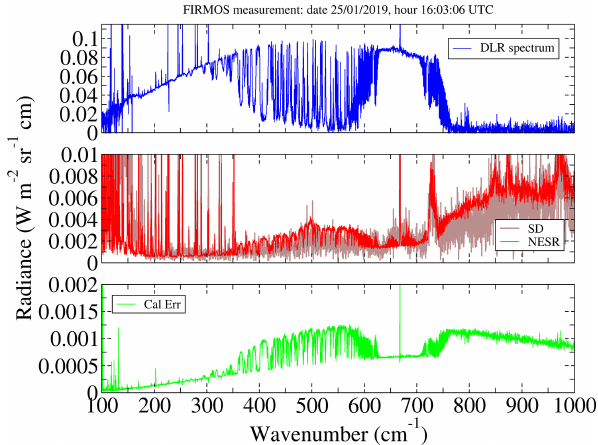
Figure 7. Example of FIRMOS DLR spectrum and the associated noise estimates acquired on 25 January 2019, 16:03UTC.